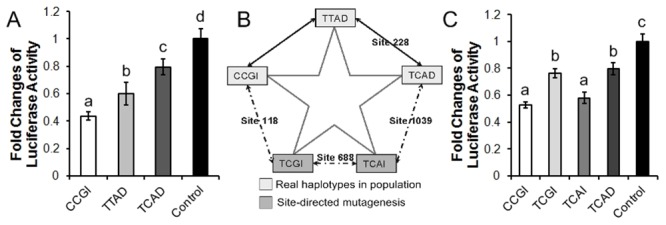
Effects of three major haplotypes and alleles of the four SNPs on DLX3 3′UTR reporter gene activity.(A) Relative luciferase activities of the three major haplotypes of sheep DLX3 3′UTR. The reporter activity was expressed as relative luciferase activity (Rluc/Fluc ratio). The psiCHECK2 empty vector was used as a control. Different letters (a, b, c and d) above columns indicate significant difference between groups (p < 0.05). (B) Strategy applied to construct novel haplotypes. Three major haplotypes (CCGI, TTAD and TCAD) were present in our tested population. In order to investigate the allelic effects of each of these four SNPs, two novel haplotypes (TCGI and TCAI) were constructed by use of a One-Tube Point Mutation Kit (TIANDZ, China). The allelic effects of SNPs 1 to 4 on reporter gene activity were measured by comparing between CCGI and TCGI for SNP1, between TTAD type and TCAD for SNP2, between TCGI and TCAI for SNP3, and between TCAI and TCAD for SNP4, respectively. (C) Relative luciferase activity of the haplotypes of sheep DLX3 3′UTR. The psiCHECK2 empty vector was used as a control. Different letters (a, b and c) above columns indicate significant difference between groups (p < 0.05). All reporter assays were performed in SFFs. Data are representative of at least three independent experiments (error bars, S.D.).